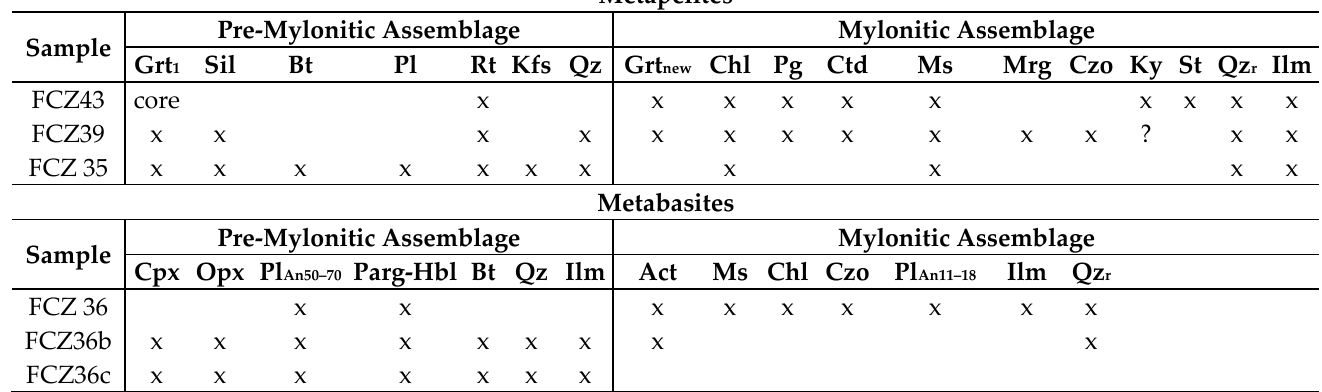
Table 1. Mineral paragenesis developed during pre-mylonitic and mylonitic events in metapelite and metabasite